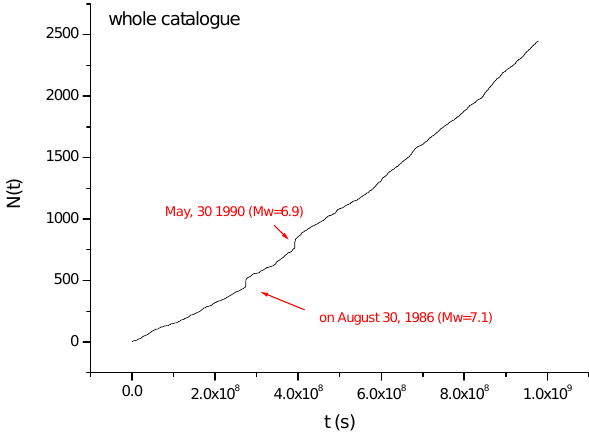
Fig. 1. Spatial distribution of the sub-crustal earthquakes of the Fig. 1 Vrancea zone for the period 1978–2008.